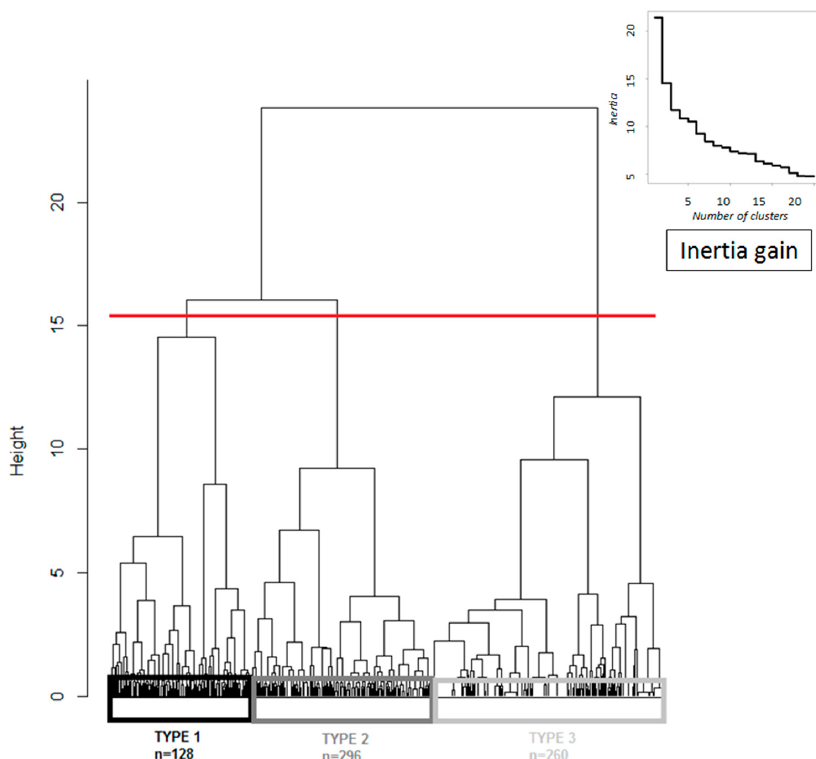
Figure 5. Dendrogram of individuals from Agglomerative Hierarchical Clustering performed on the first 12 components of the Multiple Correspondence Analysis. Type 1 are large, diversified and productivist farms. Type 2 are small, marginal rainfed farms. Type 3 are small, irrigable marketing farms. Using the first 12 principal components in an Agglomerative Hierarchical Clustering (AHC) algorithm, we obtained a typology with three farm types (red line). Jump in between-cluster inertia is represented in the right corner.